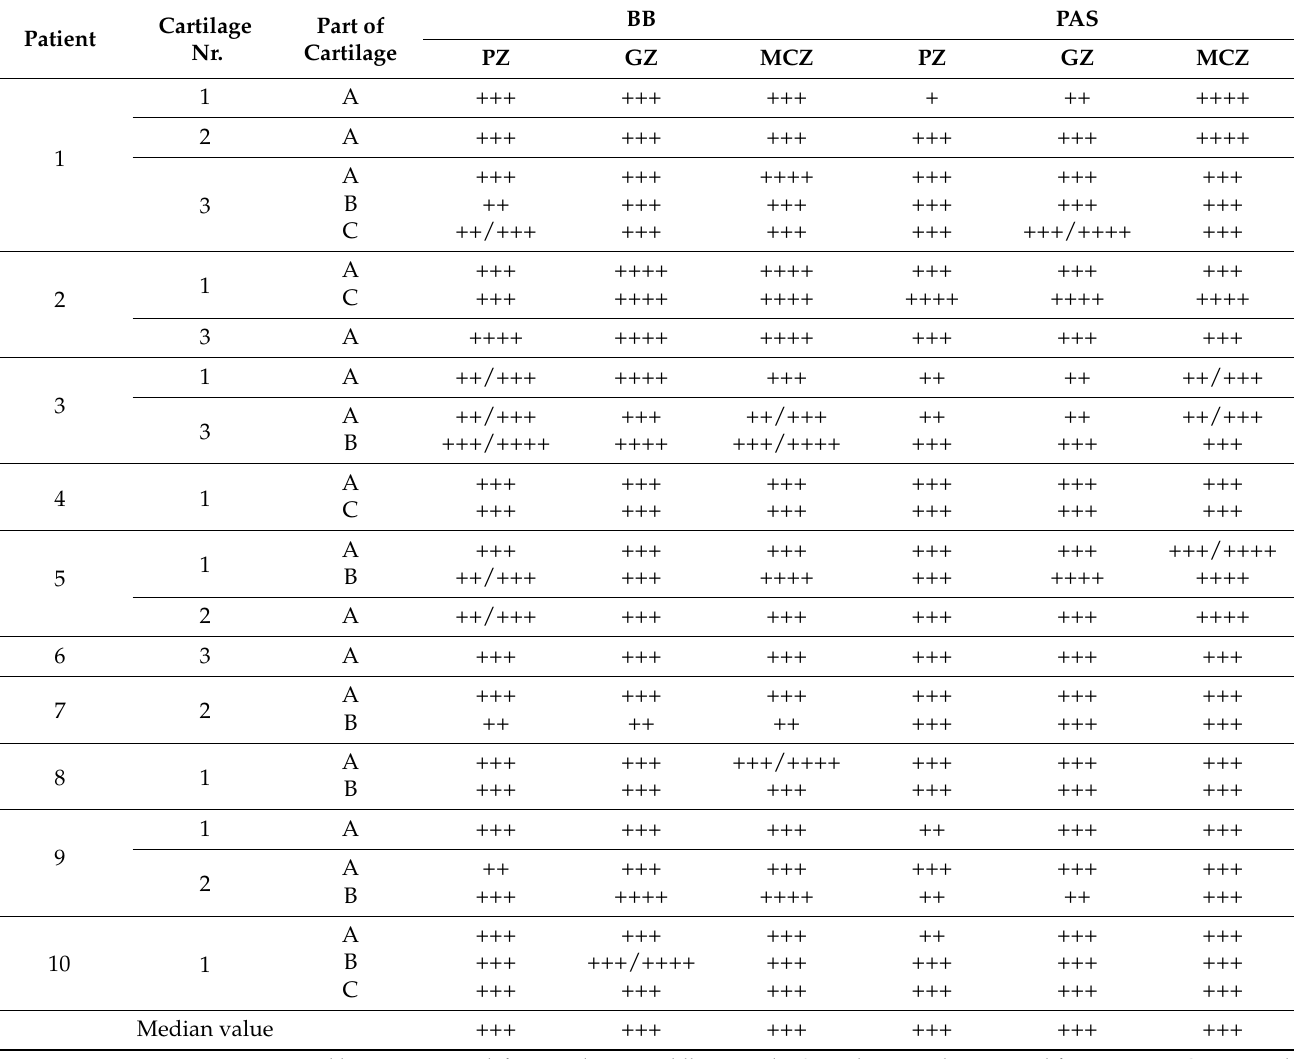
Table 2. Relative number of Bismarck brown and Periodic acid–Schiff positive cells in different tracheal hyaline cartilage